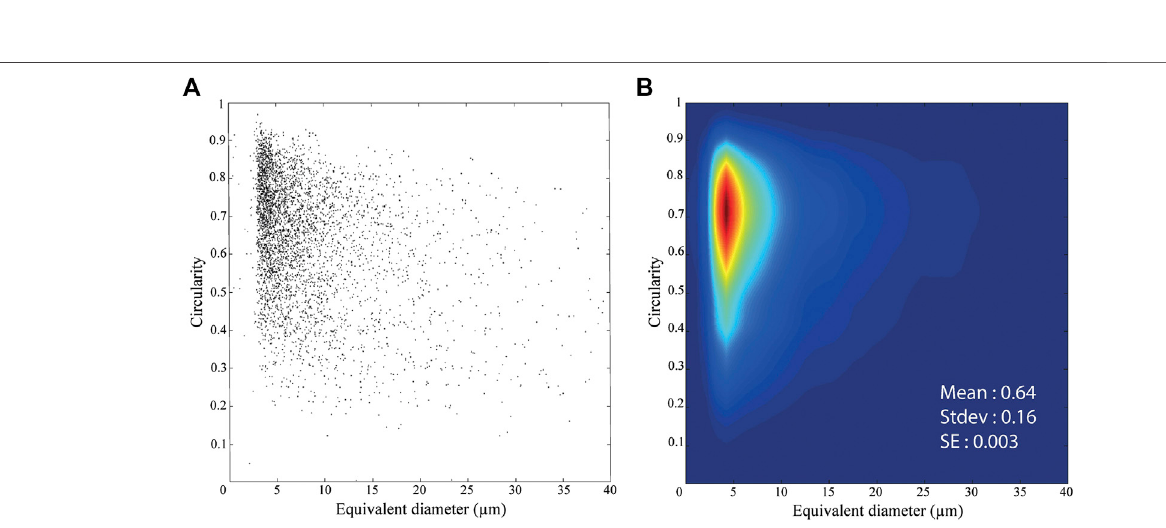
FIGURE 5 | Example of particle shape distribution plot. Circularity against equivalent diameter (S) diagram for clasts in tonalite hosted pseudotachylite before (A) and after (B) contouring. Associated mean, standard deviation ( σ ) and standard error ( σ x ) are indicated. Colors are representative of point concentration with blue representing the low concentration and red high